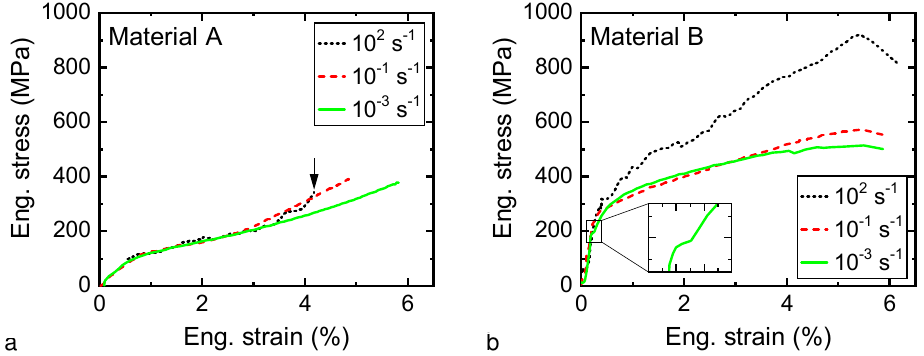
Fig. 3: Stress / strain diagrams of materials A and B at di ff erent strain